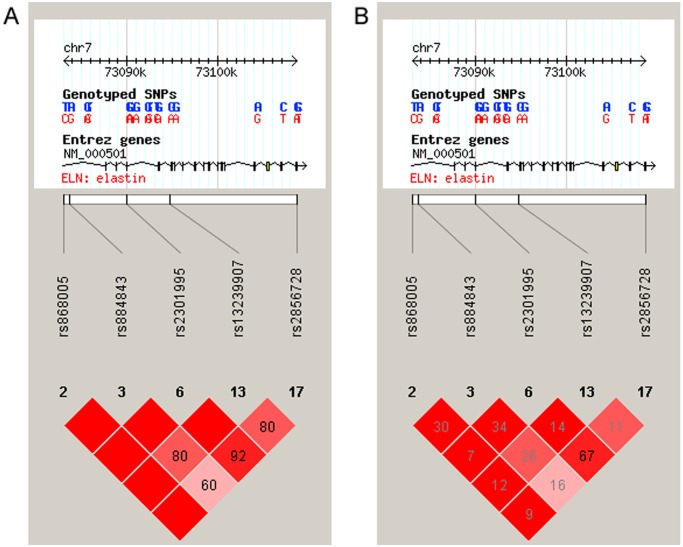
Position and linkage disequilibrium (LD) plot for 5 tag SNPs.LD values are presented by (A) D’ and (B) r2.